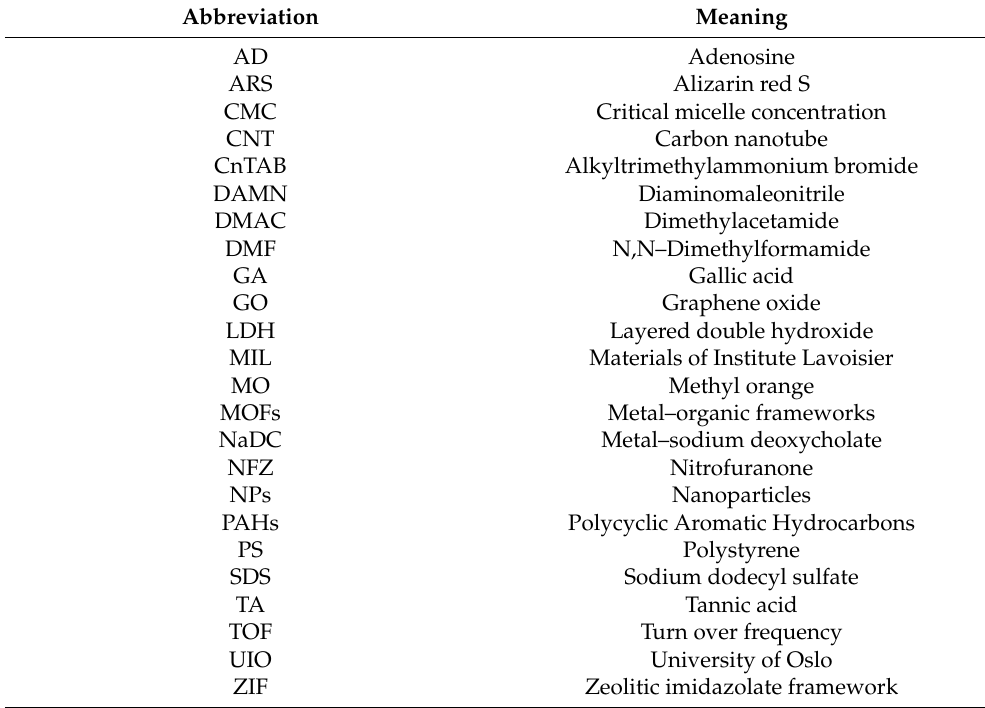
Table 1. A list of abbreviations used in this review